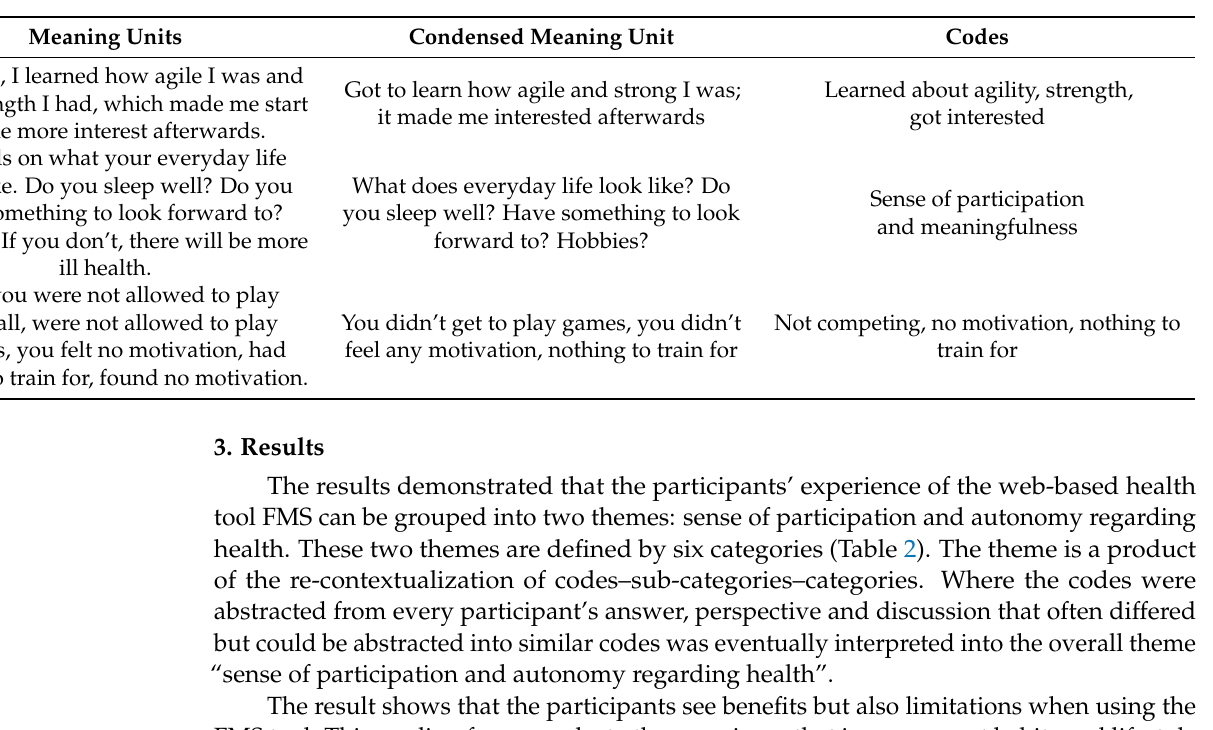
Table 1. Examples of the condensation of meaning-bearing units into